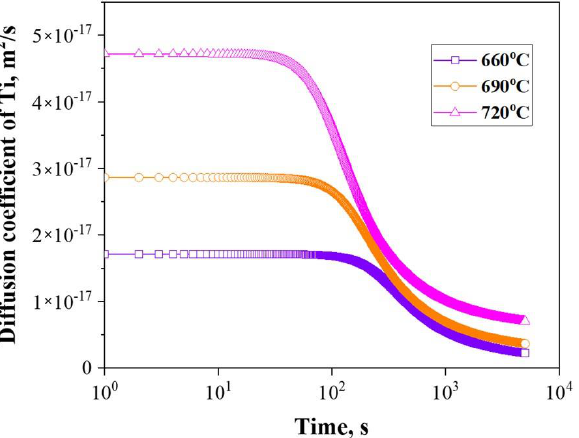
Figure 5. Driving force and grain boundary mobility versus isothermal time for varied temperature: ( a ) driving force and ( b ) grain boundary mobility.